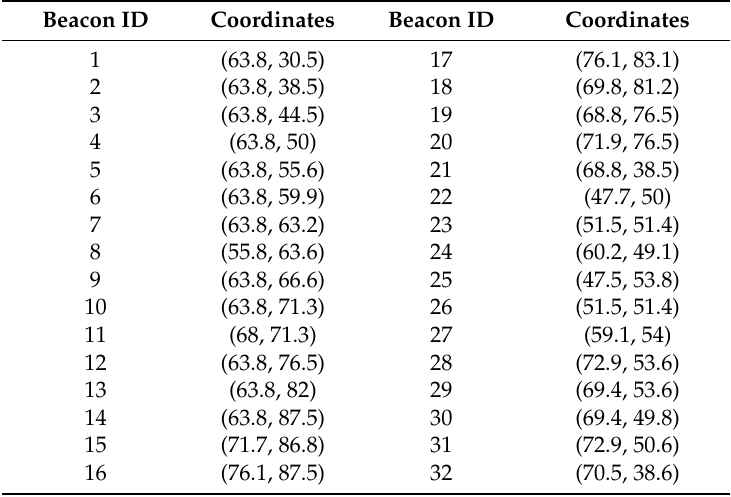
Table 1. The coordinates of the deployed BLE beacons.